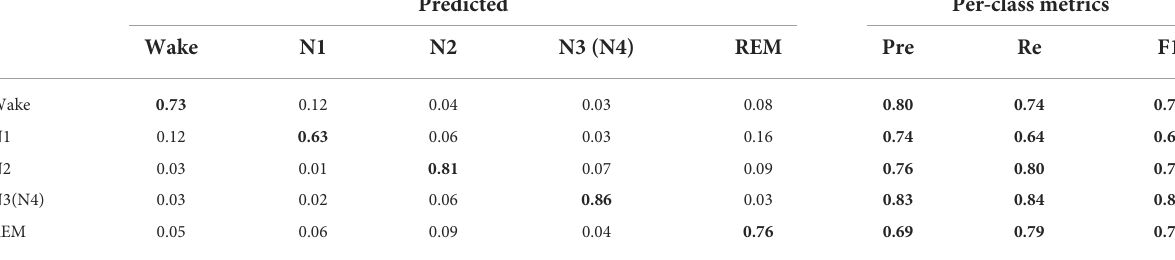
TABLE 5 Confusion matrix for each stage after L loss RDB- DCGAN data augmentation.